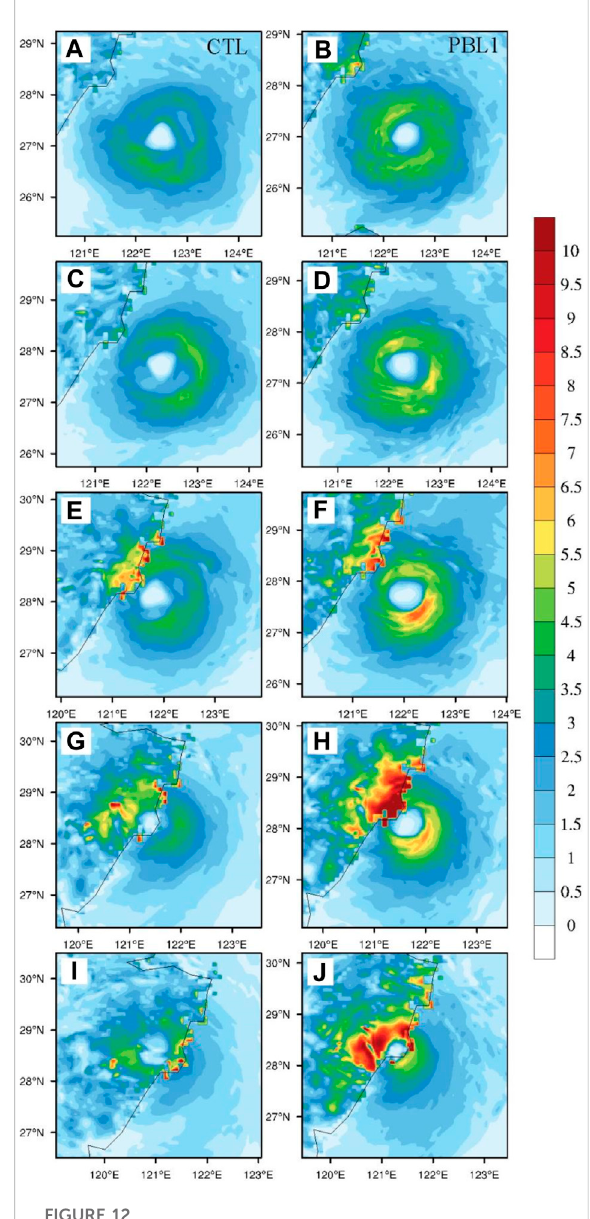
FIGURE 12 Surface momentum fl ux [unit:kg/(m s 2 )].during 12:00 UTC on 9 August 2019 to 00:00 UTC on 10 August 2019 from (A,C,E,G,I) CTL, and (B,D,F,H,J) PBL1, at (A,B) 12:00 UTC on 9 August,